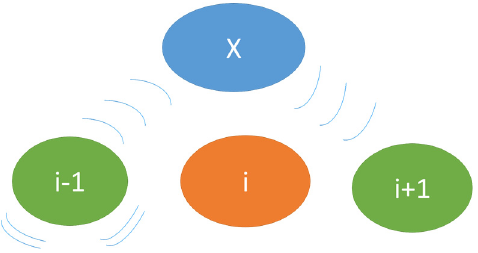
Figure 11. Fix for scenario when malicious node drops CPs.